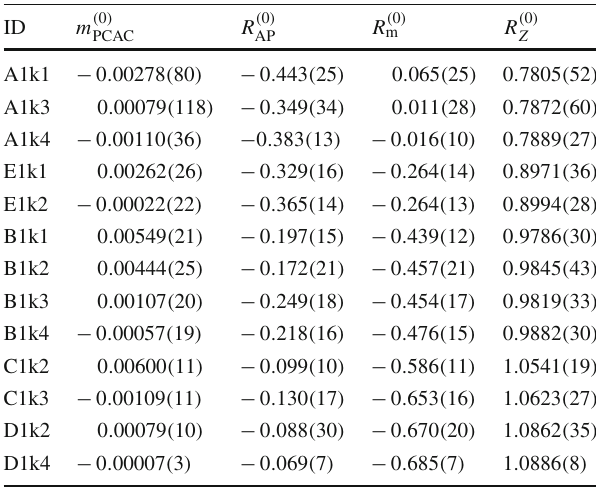
Table 7 Sea quark PCAC masses and estimators R AP , R m and R Z for LCP-1 (i.e., at the partially-quenched point) in the sector of vanishing